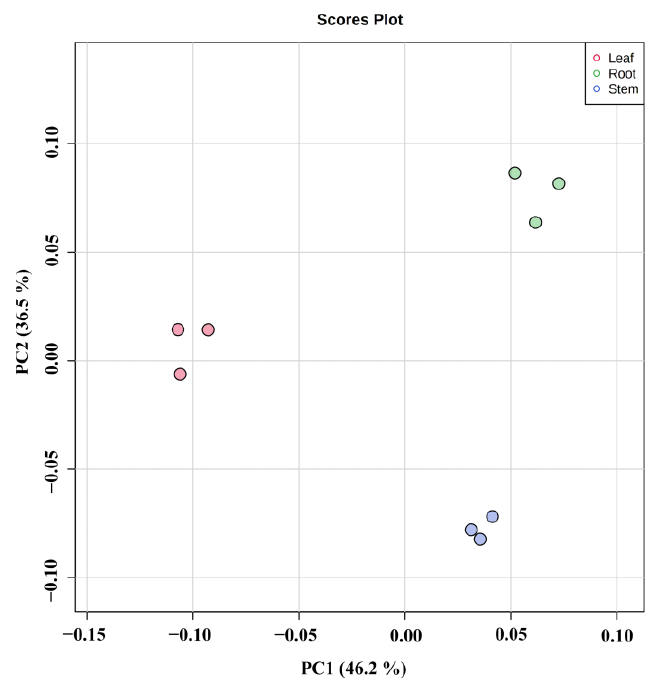
Figure 4. PCA score plot in different parts of Houttuynia cordata .